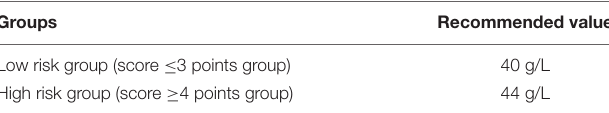
TABLE 7 | Preoperative serum albumin recommended value based on the scoring scale.